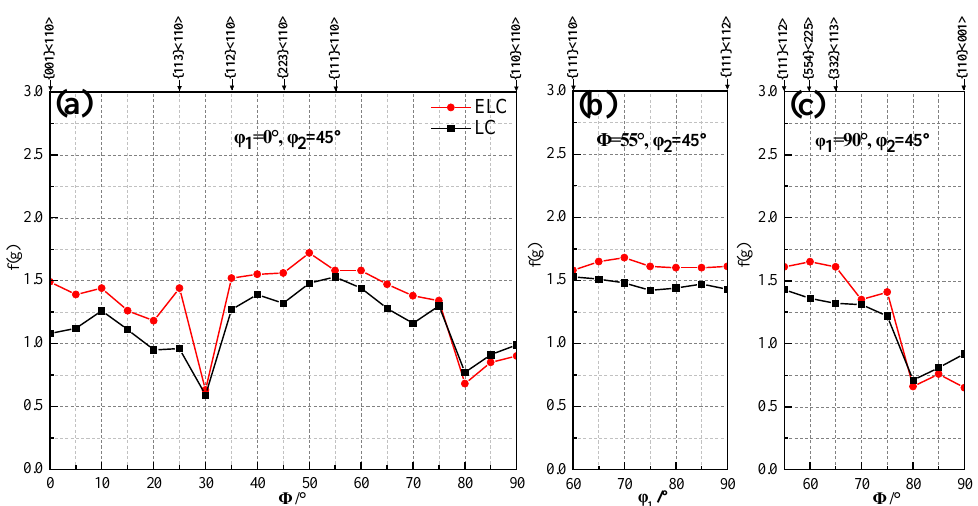
Table 2. The intensity function value on the ND orientation line changes little, indicating tensity function values at {554} <225> and {332} <113> on the TD orientation line increase and those of LC decrease, indicating that ELC is more likely to produce ear on the rolling direction of 0°/60°, which can balance ear on the rolling direction of 45° and reduce the earing coefficient [30].